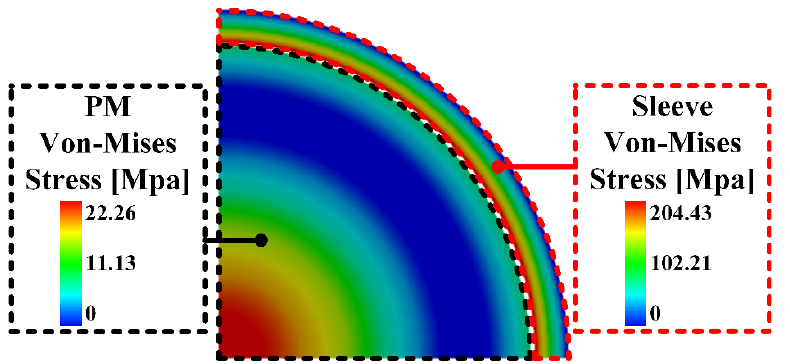
Figure 6. Analysis result of rotor von Mises stress.